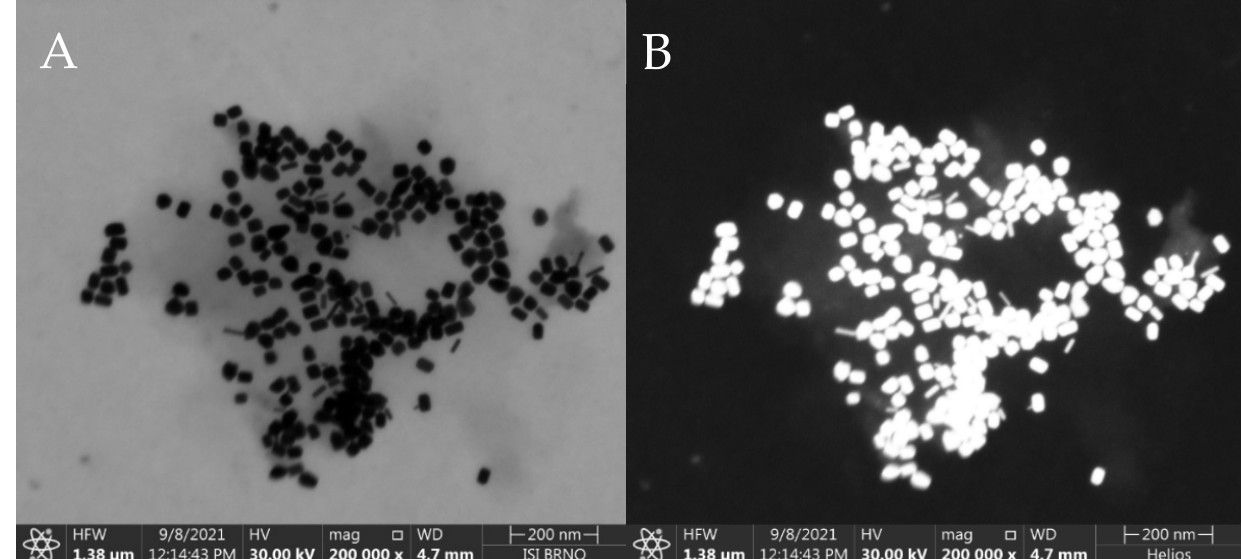
Figure 2. SEM image of the synthesized AuNRs placed on a thin carbon film. Taken at 30 kV, 50 pA with transmission detector in ( A ): Bright Field, ( B ): High Angle Annular Dark Field mode. Instrument: Helios G4 (Courtesy of Thermo Fisher Scientific). Average dimensions: ( ≈ 90%): 40 ± 4 nm × 24 ± 2 nm, ( ≈ 10%): 42 ± 4 nm × 8 ± 2 nm. Measurement parameters cf.